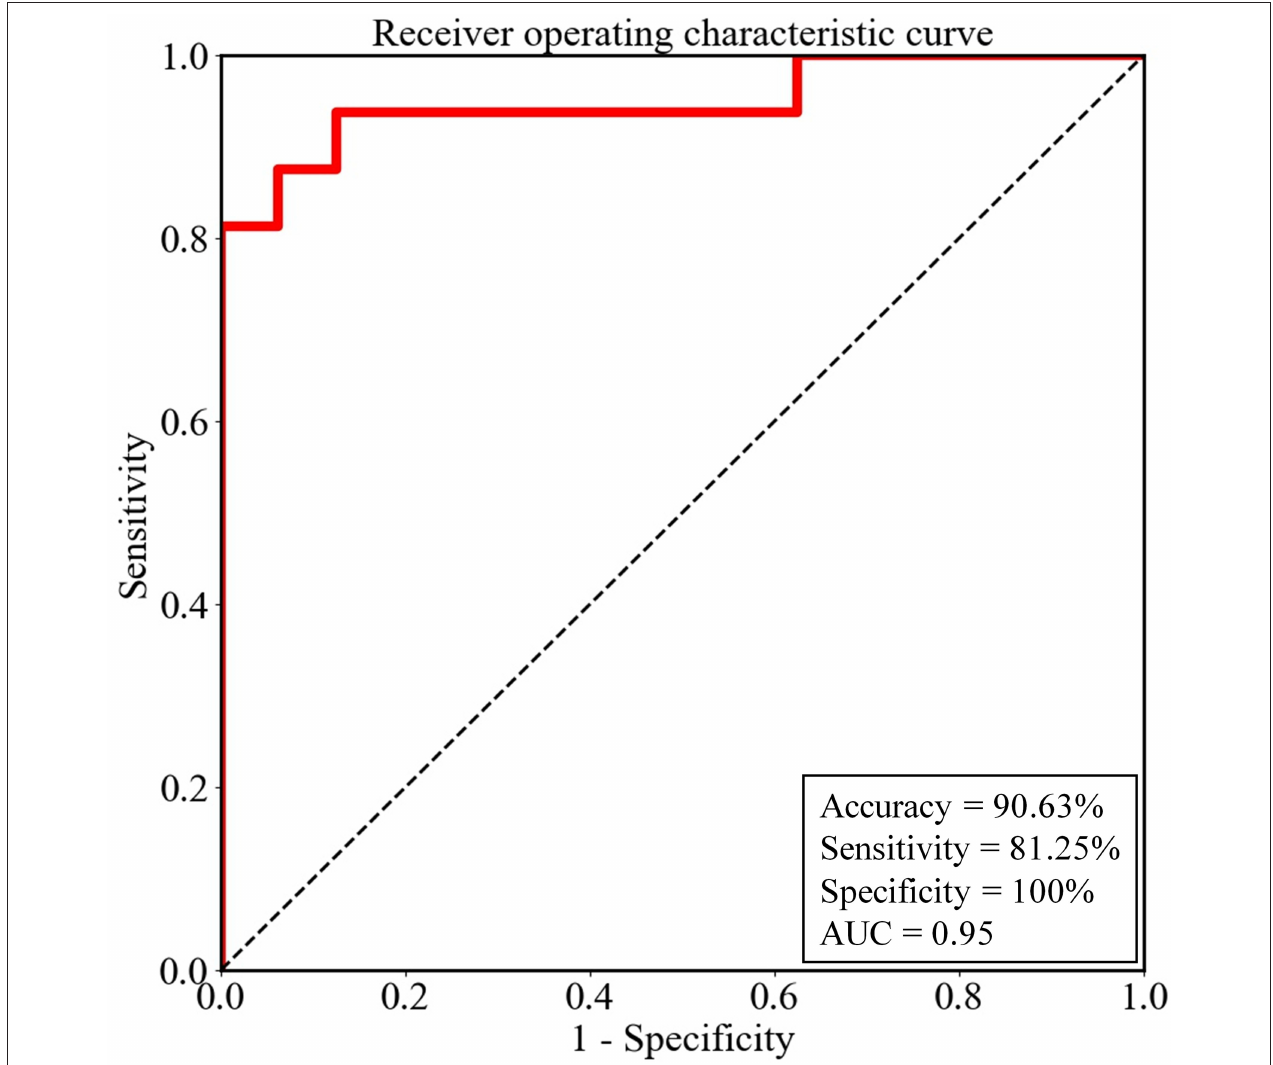
FIGURE 3 | The performance of the logistic regression model for the testing cohort was evaluated by the receiver operating characteristic (ROC) curve. AUC, the area under the ROC